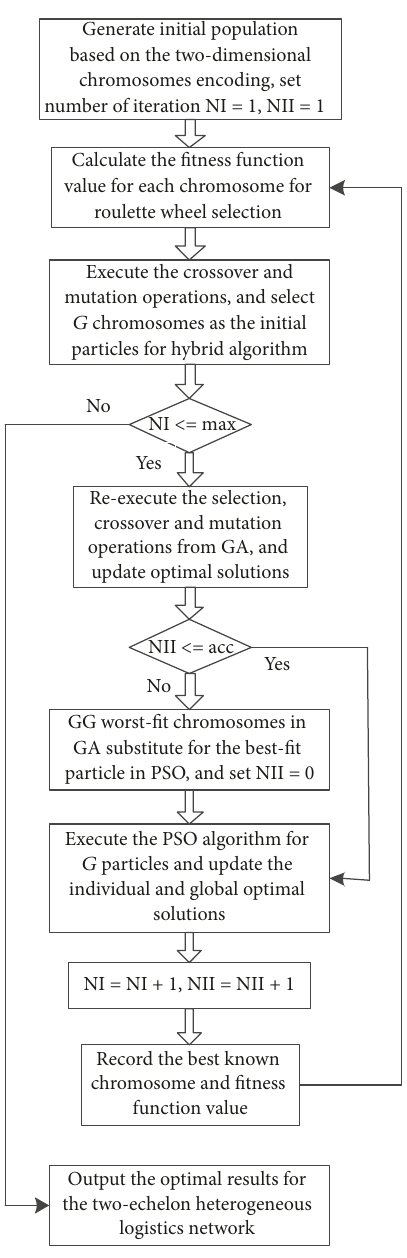
Figure 3: The flowchart of hybrid algorithm